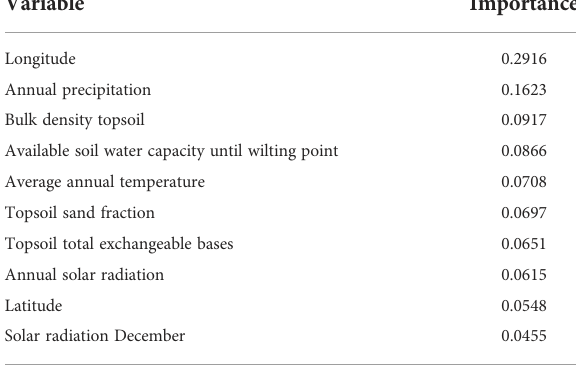
TABLE 1 Variable importance for the Random Forest predictor.